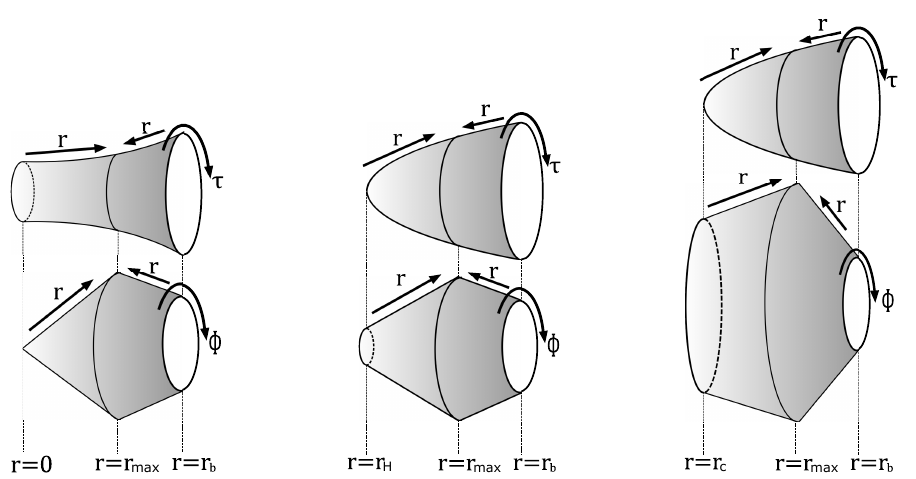
JHEP09(2021)121